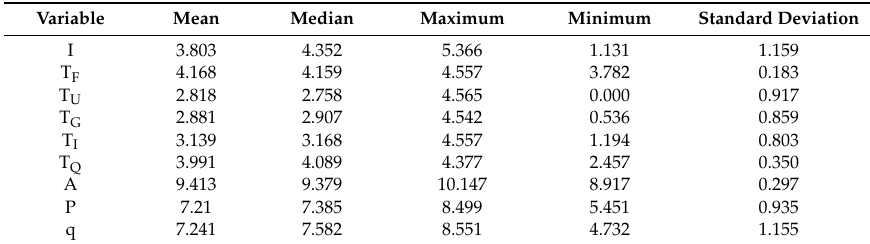
Table 1. Descriptive statistics for each